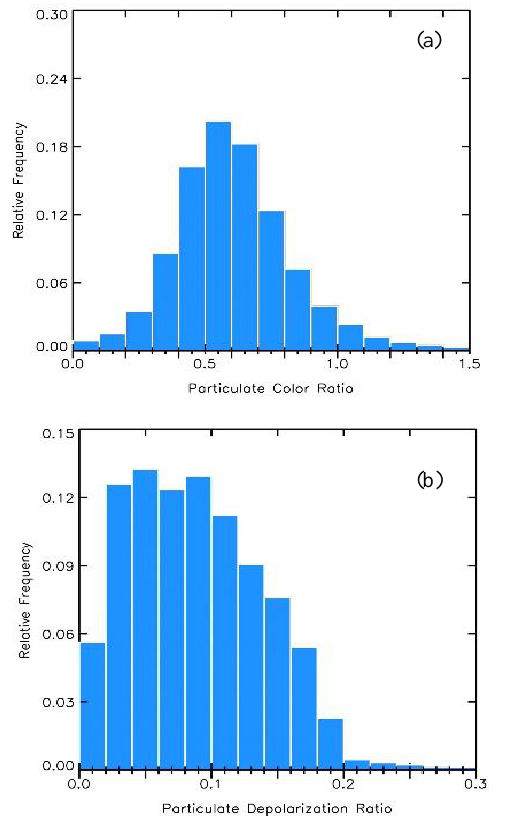
Figure 5 Histogram of (a) particulate color ratio and (b) depolarization ration derived from CALIPSO satellite over central-eastern China for winters